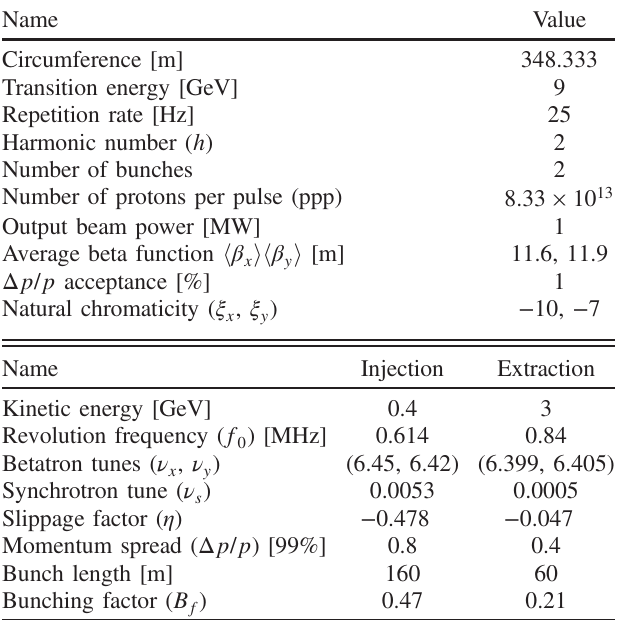
FIG. 1. Schematic view of 3-GeV RCS at J-PARC. The eight pulsed kicker magnets (KMs) placed in the second straight (extraction) section are used for beam extraction. The extracted beam is delivered simultaneously to the MLF and MR. The transverse impedance of the KMs is a strong source of beam instability in the RCS. The time-independent parameters are given in the upper half, while time-dependent ones are listed in the bottom half of the table. Details about RCS parameters can be found in the J-PARC technical design report [1]. TABLE I. Main parameters of the RCS [1]. The time- independent and time-dependent parameters are separated into the upper and lower halves of the table,